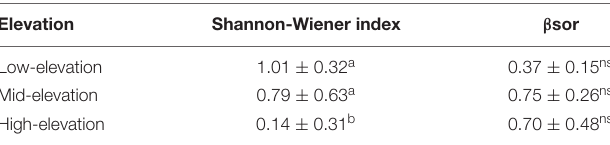
TABLE 3 | The ANOVA result of α -diversity and β -diversity among the elevational gradients in Derong